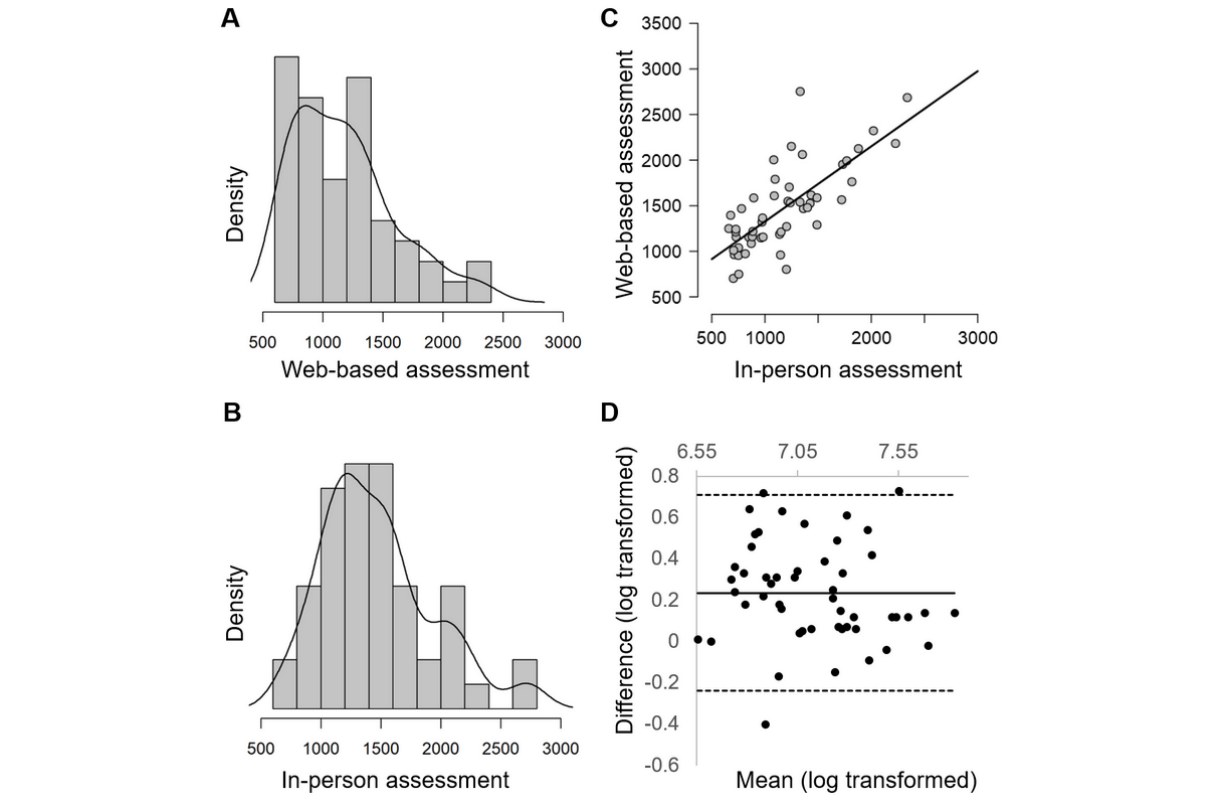
Figure 4. Comparability of Emotion Recognition Task median correct reaction time (in ms) across test settings. Density plot for (A) web-based assessment and (B) in-person assessment, showing broader distribution of timings (range 500-3000 ms) and slower overall timings for web-based assessment compared to in-person assessment (range 500-2500 ms); (C) scatterplot with reference line showing strong linear relationship between assessment settings ( ρ =0.73); (D) Bland-Altman plot: mean difference (solid black line) is shifted above zero, demonstrating bias; dashed lines show limits of agreement. Comparable magnitudes of difference are seen throughout the range of measurements, and 94% of the data within limits of